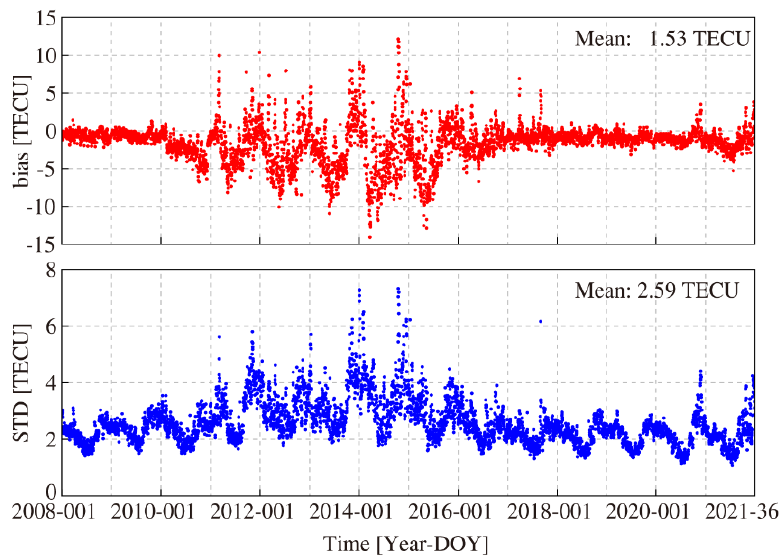
Figure 6. Time series of NeQuick2 with respect to IGSG during the test period.